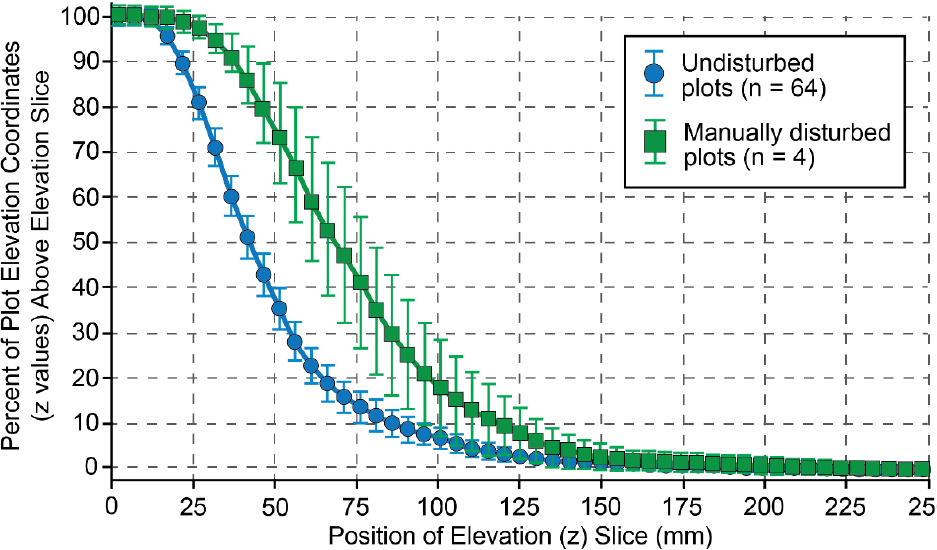
Figure 7. Results of Validation Test #1: comparison of the percentage of z-values extending varying distances above the standardized zero elevation for a given DTM for all undisturbed plots and four manually disturbed plots surveyed.